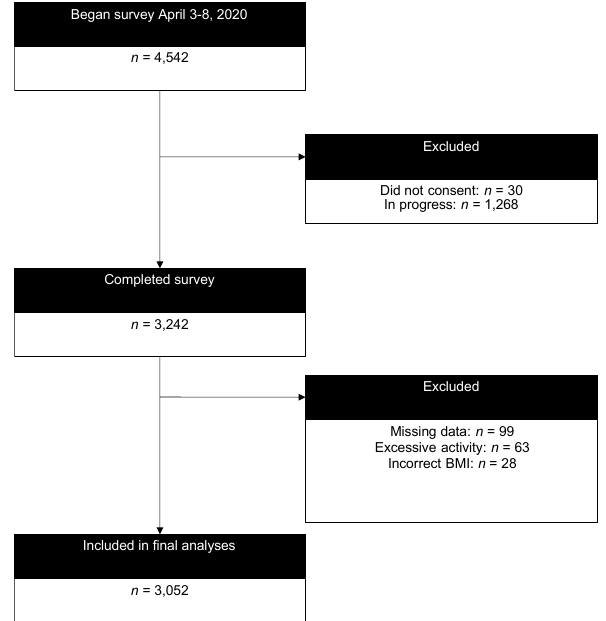
Figure 1. CONSORT diagram of participation. Table 1. Participant characteristics ( n = 3052).